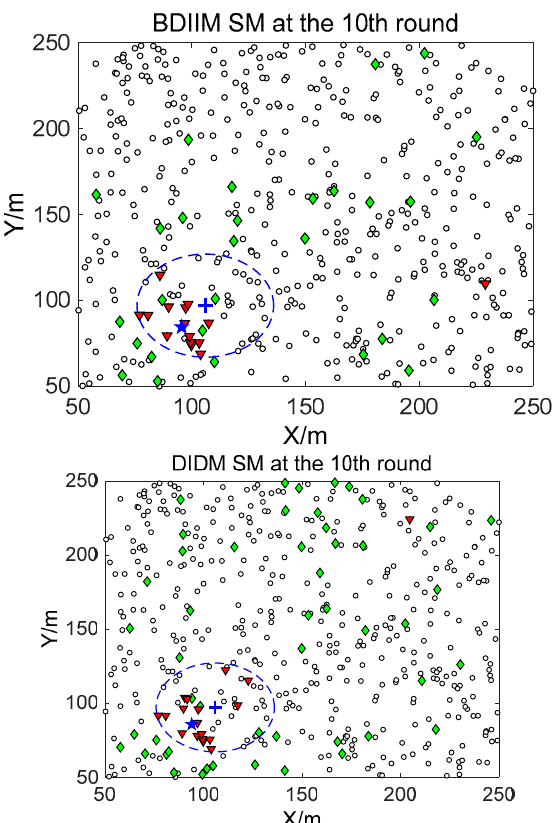
Figure 5. The state of the sensing module (SM) at the 10th time interval.